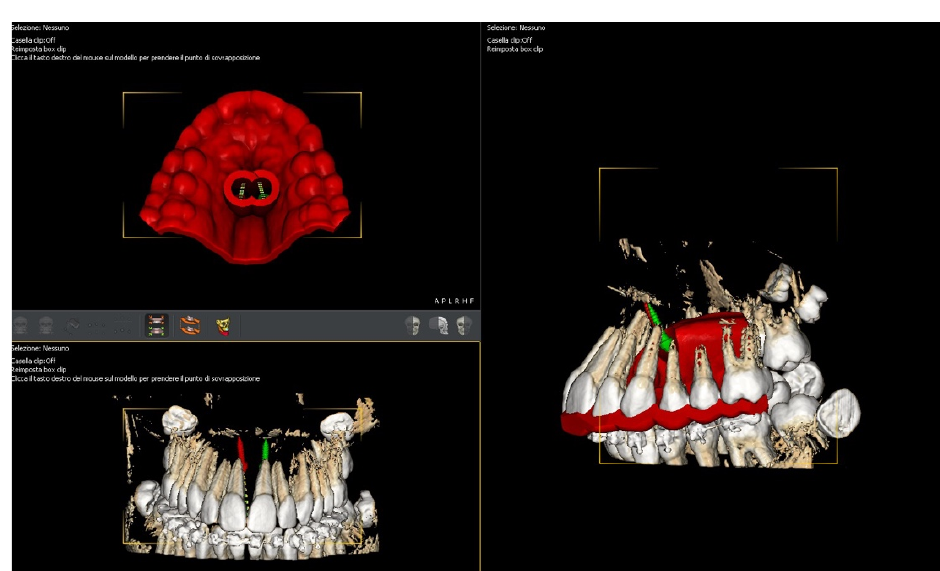
Figure 9. Digital planning with Easy Driver ® protocol.